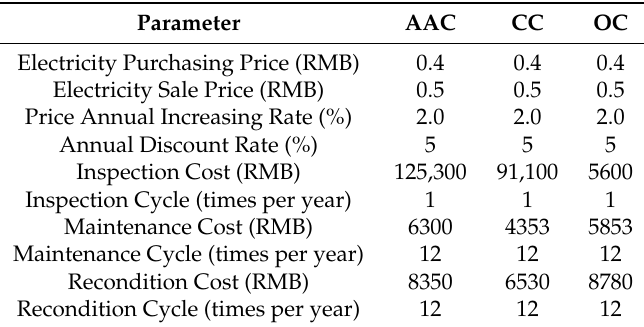
Table 3. Operation and maintenance parameters in Case